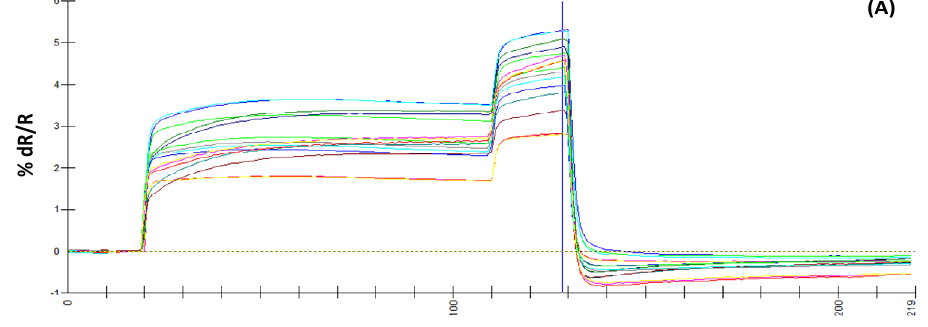
Figure 1. Typical sensor-response outputs from representative samples of healthy wood blocks (controls), inoculated wood blocks (decayed) and wood decay fungi pure cultures. Sensory array output are from: (A) a non-inoculated sample of Quercus lyrata , (B) a partially decayed wood sample of Q. lyrata after inoculation with Ganoderma lucidum , and (C) a sample of Ganoderma lucidum in pure culture. Histograms of normalized intensity responses of individual sensors to headspace volatiles produced by the same Q. lyrata -samples for non-inoculated (D), partially decayed (E), and pure culture (F),